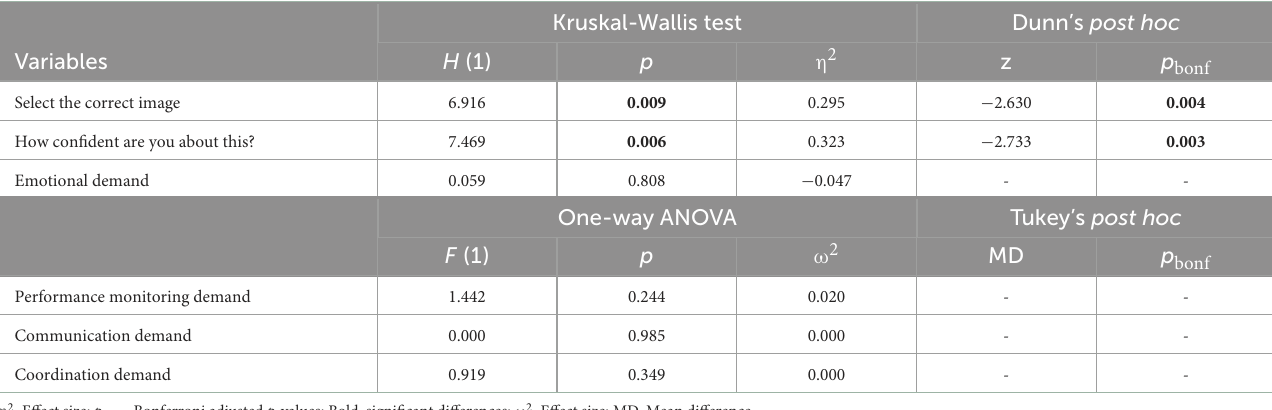
TABLE 2 Task 1 comparisons between VDE and Arkime ( N = 22).